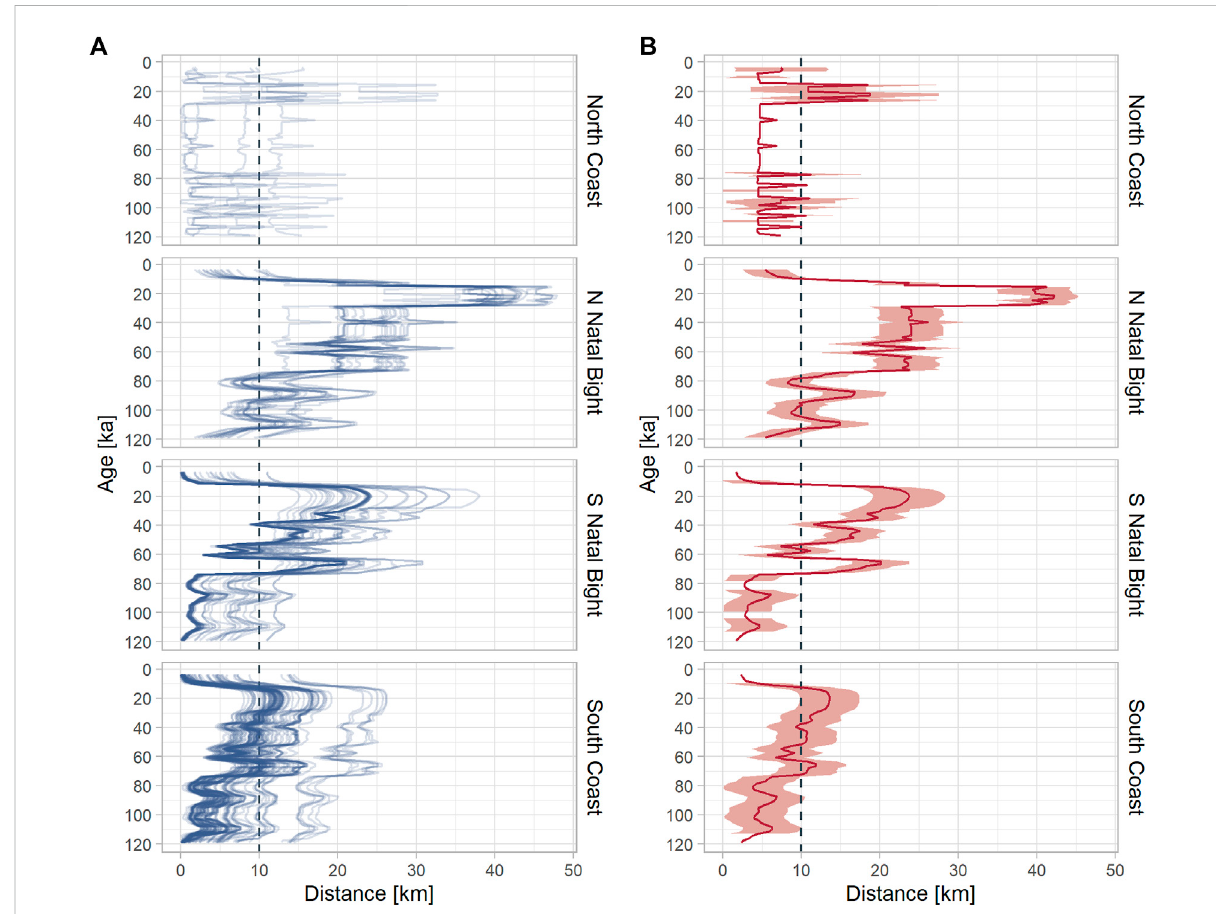
FIGURE 4 Variation of the distance of archaeological sites to the coast over time. (A) Coastal distances for 172 archaeological sites from the North Coast (n=5),NorthernNatalBight(n=19),SouthernNatalBight(n=45),andSouthCoast(n=103).Lightbluelinesshowthetimeseriesofsinglesitesanddark blue lines indicate overlapping of multiple time series. (B) Temporal aggregates of the time series show the mean (dark red line) and one standard deviation (bright red ribbon) coastal distances. The dashed lines at 10 km in (A) and (B) mark the upper boundary of daily foraging range of modern Hunter-Gatherer